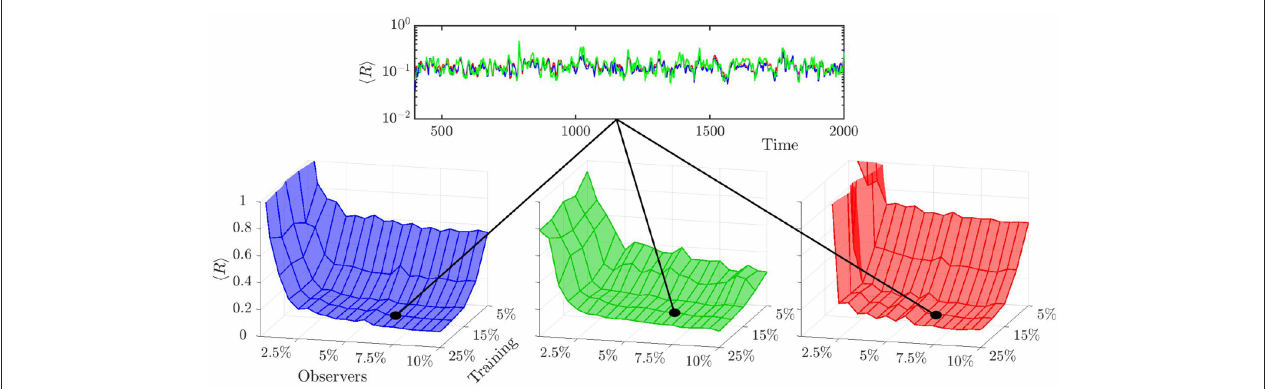
FIGURE 3 | Normalized RMSE ( < R > ) of RC, OLSTM, and the OFNN methods calculated for each time step over all system nodes at each predicted time step (top panel) and over the predicted time steps and all system nodes (bottom 3-dimensional plots) as a function of the number of observers (given as percentage of the entire number of system nodes) and the size of the training dataset (given as percentage of the entire ground-truth time series) for the chimera depicted in Figure 2 . The black dots in each of the 3-dimensional plots represent the normalized RMSE for each ML method, respectively, at a randomly picked time step, calculated overall system nodes and previous time steps, but not counting observer nodes and training time steps. Red: OLSTM, green: RC, blue: OFNN. Axes, tick marks, tick labels, and grid lines are the same in all 3-dimensional